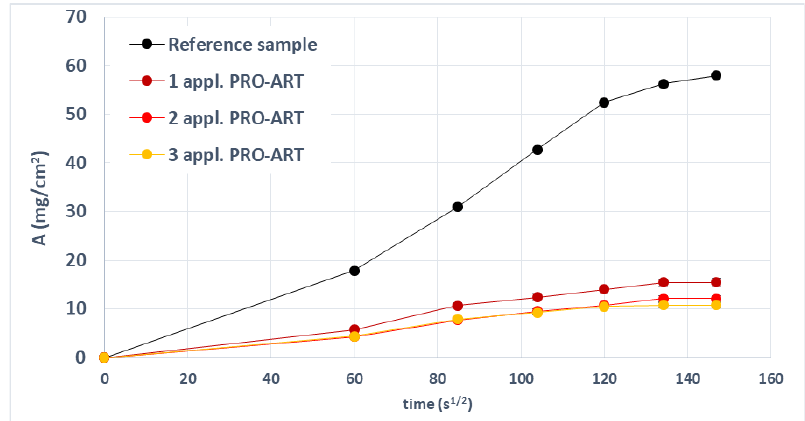
Figure 4. Absorbance over time detected on samples uncoated and coated with PRO-ART.